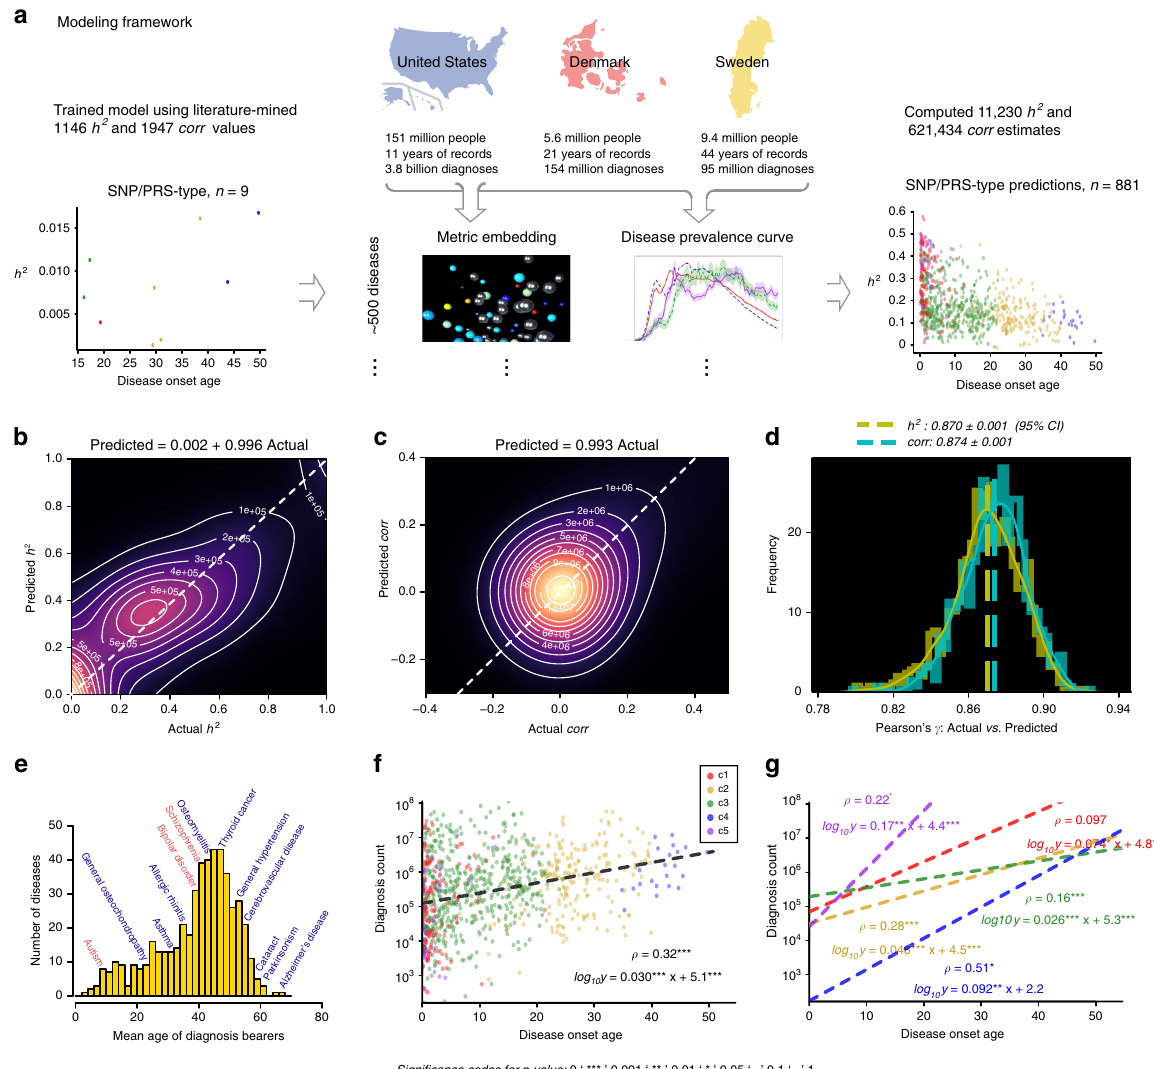
Fig. 3 Estimating population-genetics parameters for hundreds of diseases and thousands of disease pairs. Here, h 2 denotes heritability, and corr is a correlation between a disease pair which can be genetic, environmental, or phenotypic. a A work fl ow explains the key steps of our model development. We used three national-scale health registries, representing the United States, Denmark, and Sweden, which comprised 3.8 billion, 154 million, and 95 million disease diagnoses, respectively. We computed curves re fl ecting disease prevalence by age and sex (disease prevalence curves) and derived a metric mapping (disease embedding in metric space) for the whole disease spectrum. We used these two complementary representations to estimate hundreds of thousands of disease-speci fi c parameters. We then validated the accuracy of our model ’ s predictions by benchmarking them against previously- published ( “ actual ” ) estimates that were not used in model training. Plates b and c show kernel density estimation plots we computed from 1000 random 4:1 splits of data (4/5 for training and 1/5 for testing). We used these plots to visualize the joint distribution of the actual data for testing and model- predicted values. The linear fi t slopes between the actual and predicted values are 0.996 for h 2 and 0.993 for corr , indicating nearly perfectly unbiased estimations. d The distributions of Pearson ’ s correlations between the actual and predicted values have mean values of 0.870 for h 2 and 0.874 for corr . e A distribution of the mean age of disease-speci fi c diagnosis bearers. The median of the mean ages over all diseases is around 42 years, and speci fi cally, the mean ages of autism, bipolar disorder, and schizophrenia that appeared in the US data are 9, 40, and 41, respectively. f There is a signi fi cant positive correlation between disease onset age and diagnosis count in the US data, suggesting there are less-than-expected, rare, late-onset diseases. g The relationship also holds for each of the fi ve disease clusters. For individual clusters ( c 1 – c 5), we show the best linear approximation, regression coef fi cients ( p values were computed using Student ’ s t test), and Spearman ’ s correlation ρ ( p values were computed using algorithm AS 89), color-coded by the shape cluster. Superscript asterisks indicate signi fi cance level of the estimates being different from driven to lower prevalence through negative selection; and (3) a heritability. The relevant legacy estimates were sparse (Fig. 4a and historical bias in biomedical discovery since early-onset diseases Supplementary Fig. 4a plot the twin/family and SNP/PRS-type were easier to document and categorize. estimates, respectively, against disease onset age). This study ’ s Because hypotheses (1) and (3) mentioned above cannot be imputation analysis added about 800 estimates to twin/family and tested with the data currently available to us, we focused fi rst on SNP/PRS-type heritability estimates. The overall linear relation- hypothesis (2) and sought evidence of a systemically increased ship between onset age and heritability was signi fi cantly, genetic load among early-onset diseases, using a narrow-sense negatively sloped (Fig. 4a, b and Supplementary Fig. 4b).